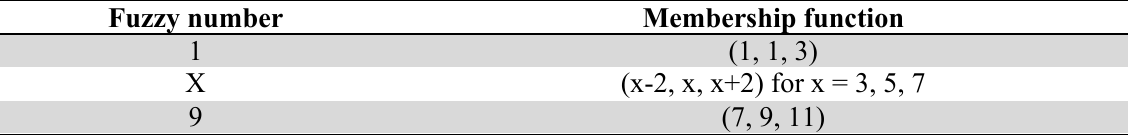
Fuzzy numbers used for making qualitative